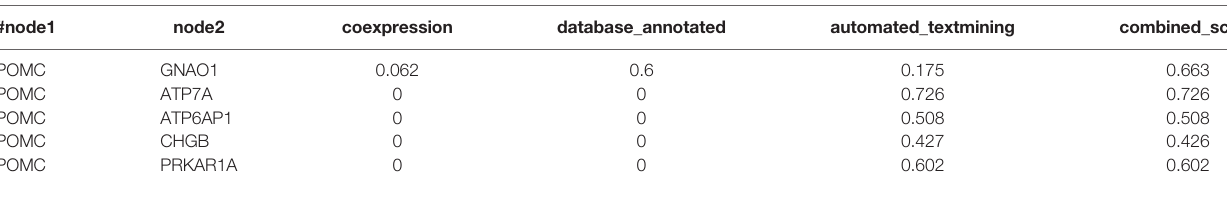
TABLE 2 | Proteins interacted with